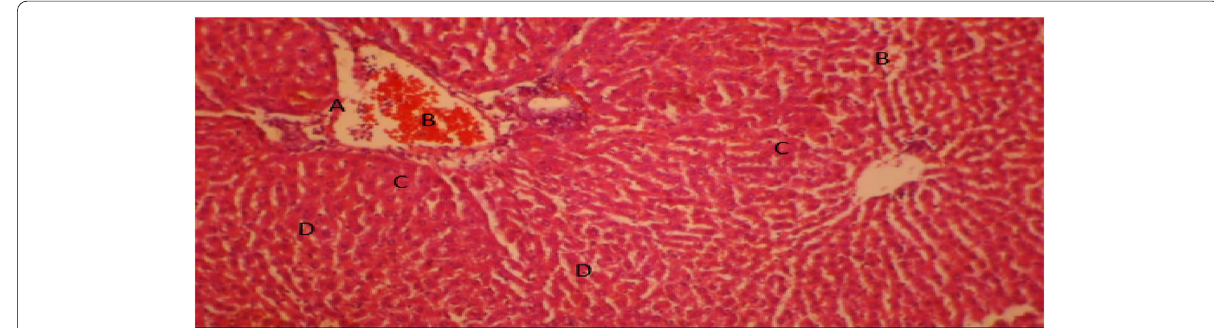
Fig. 13 Liver section of rat given 400mg/kg leaf extract only for 14 days (Group 10) showing A , marked portal vascular dilatation and B , mild active vascular congestion, C , normal hepatocytes and D , mild Kupffer cell activation (H&E x